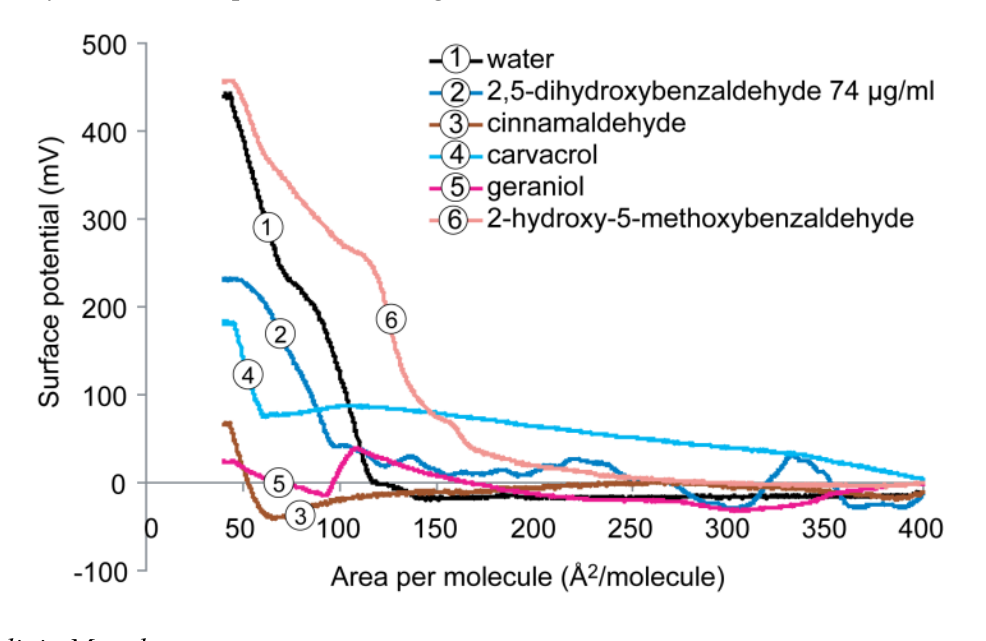
Figure 6. Surface potential versus molecular area isotherms recorded for the monolayers formed by DPPG on subphases containing water with and without